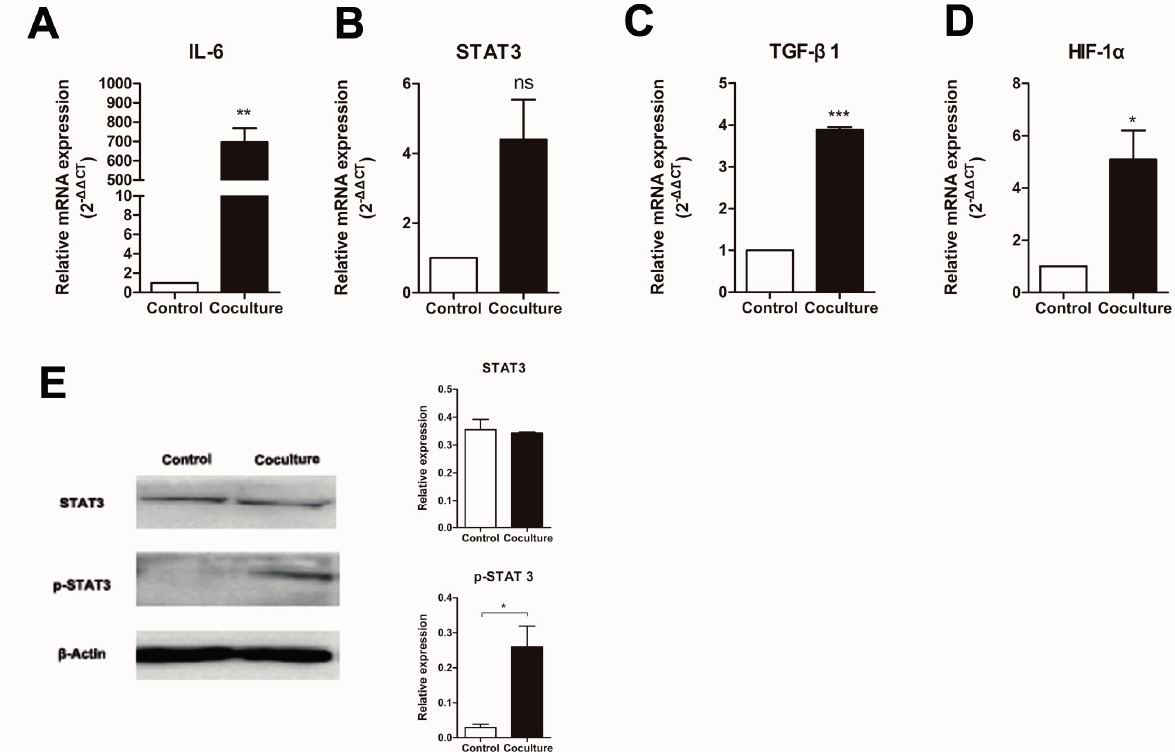
Figure 4. Changes in the expression of macrophage expressed genes in macrophages co-cultured with apoptotic MCF-7 cells. Relative amounts of mRNA of ( A ) IL-6; ( B ) STAT3; ( C ) TGF- β 1; ( D ) HIF-1 α mRNA was determined by real-time RT-PCR,